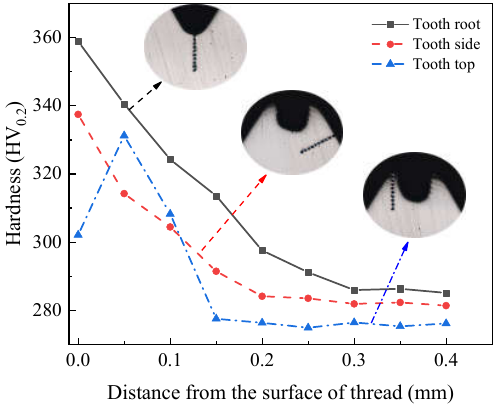
Figure 13. Measurement of thread